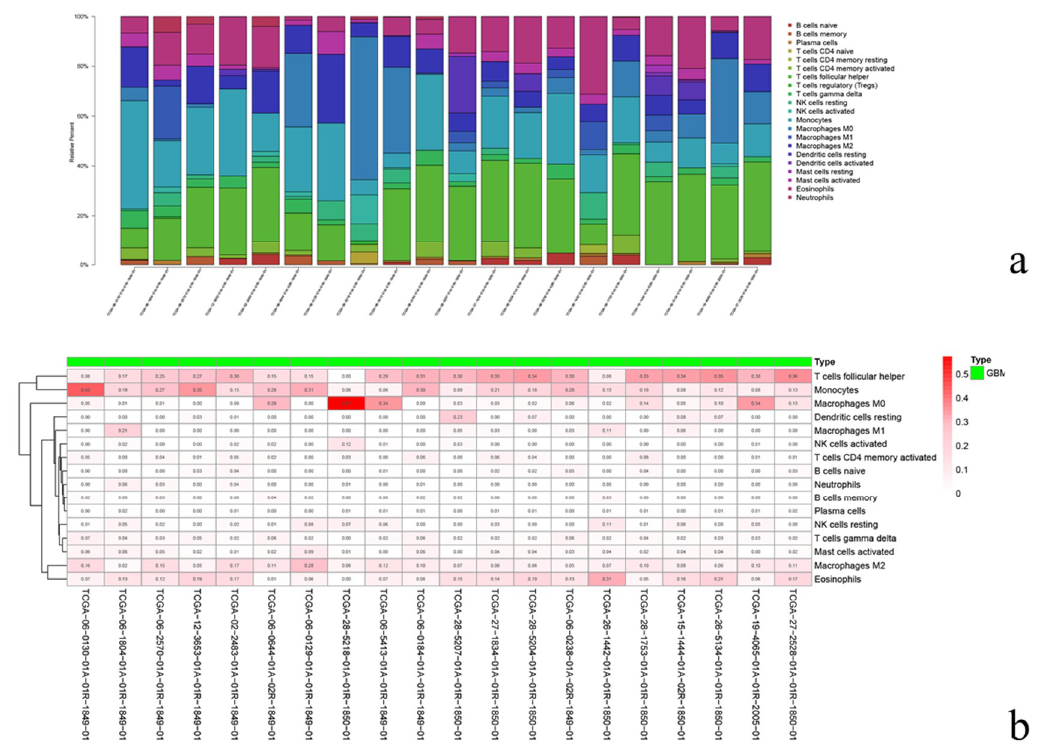
Figure 8. The percentages of different immune cells in the GBM microenvironment. In the 20 samples, each column represents a sample, and each column with a different color and height indicates the abundance ratios of immune cells in this sample ( a ). Each column represents a sample and each column with a different color indicates the percentage of immune cells in this sample ( b ).